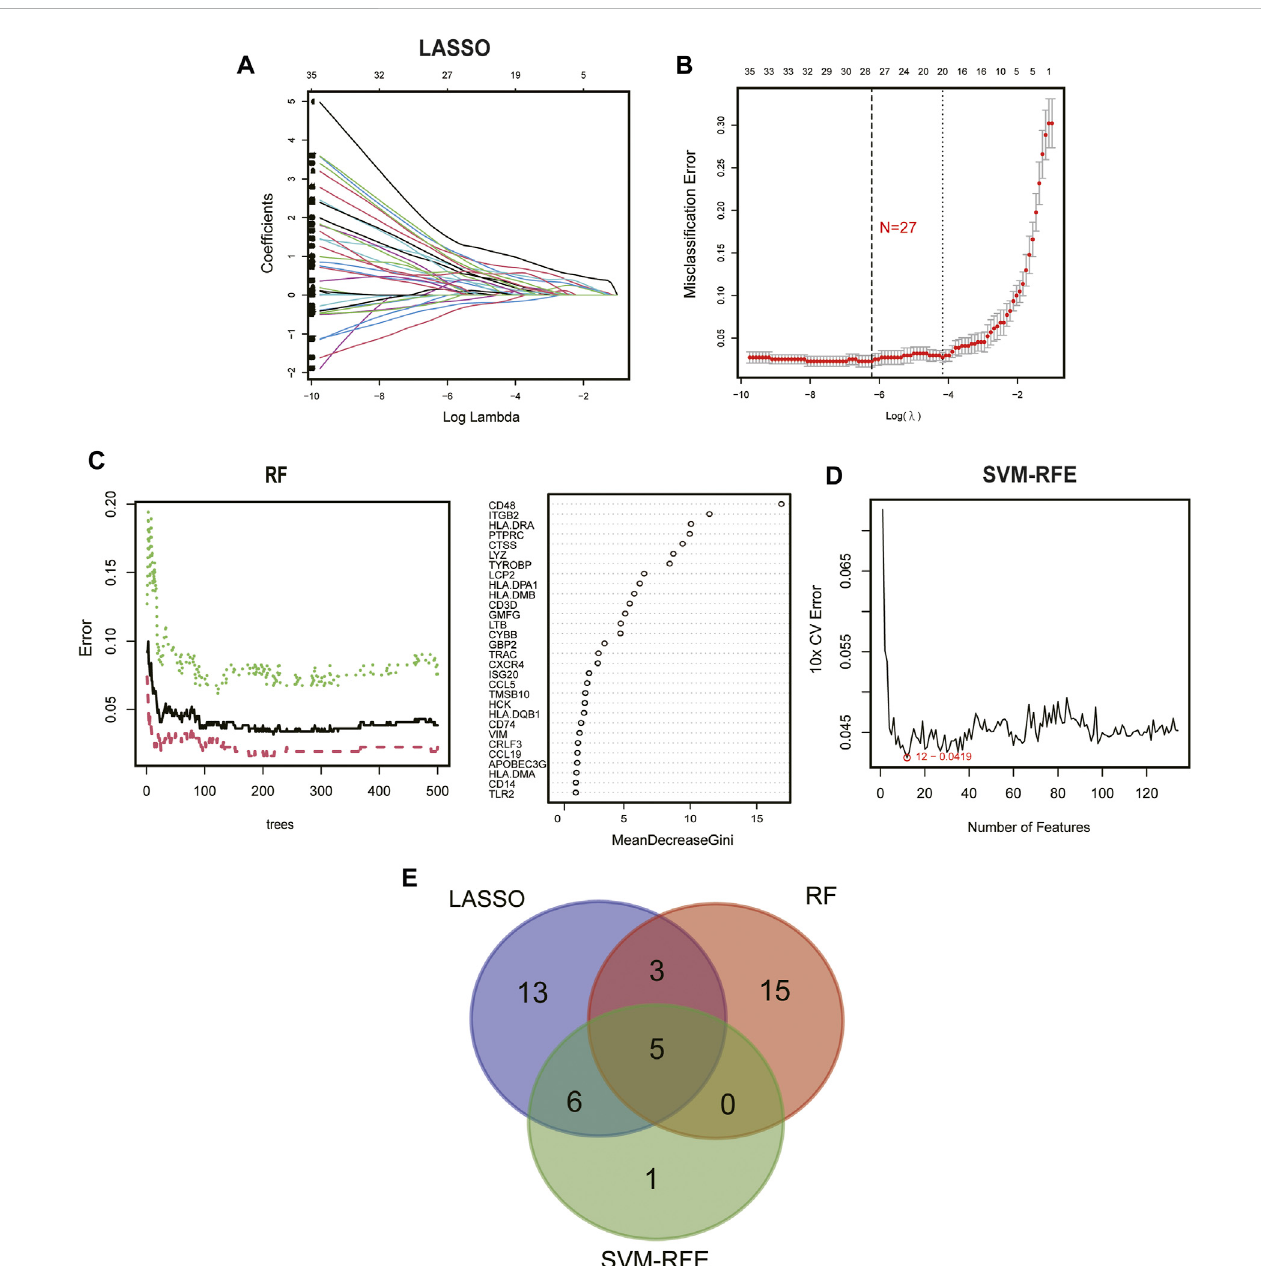
FIGURE 6 Identi fi cation of diagnostic biomarkers from subtypes using machine learning algorithms. (A) The LASSO coef fi cient pro fi les analysis. (B) Selecting the appropriate lambda value for a LASSO regression model. (C) Random forest trees constructed by cross-validation and gene ranking by importance score. (D) Estimation of 10-fold cross-validation error using SVM-RFE method. (E) Venn plot illustrating the key genes among LASSO, RF, and